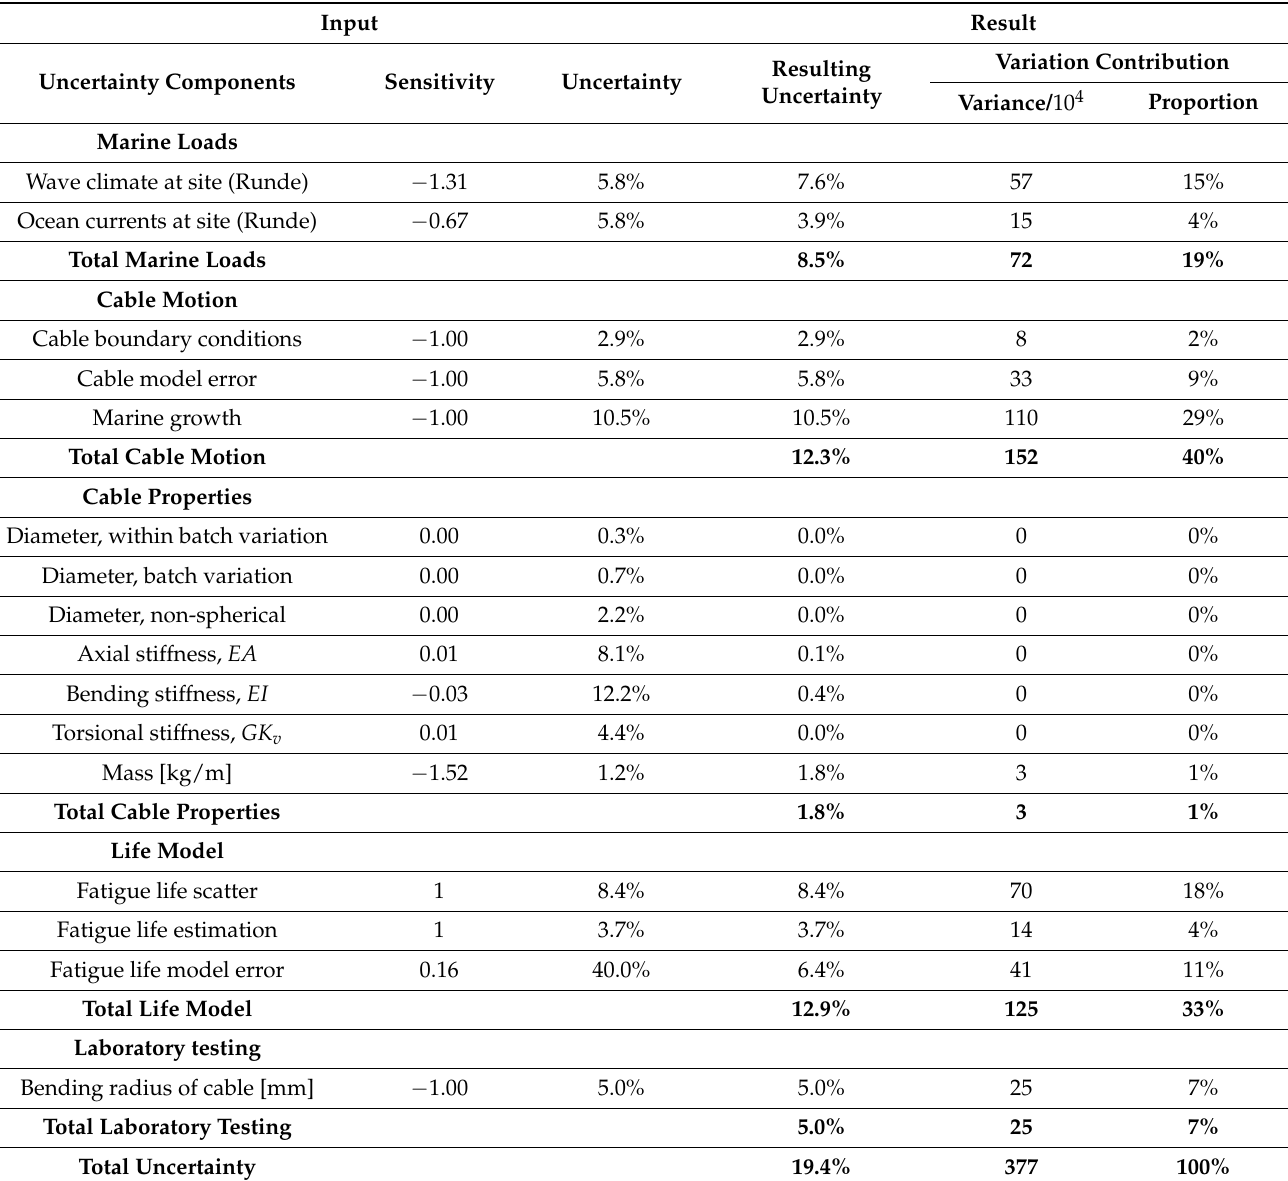
Table A1. Probabilistic VMEA for dynamic